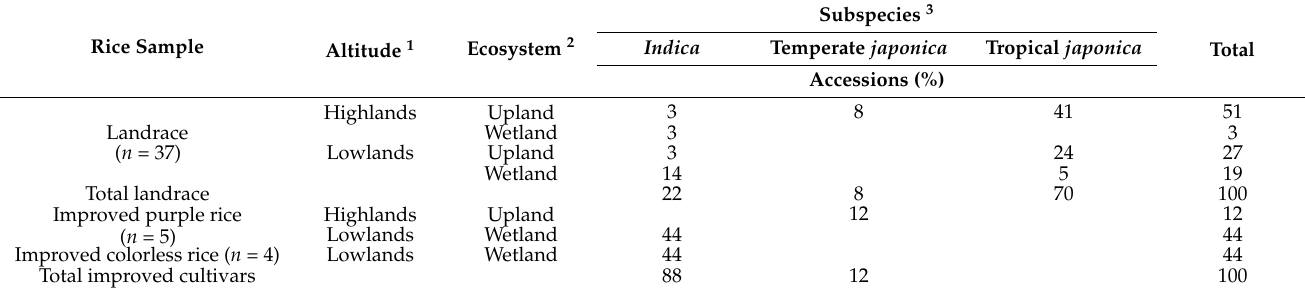
Table 1. Distribution of rice subspecies among purple rice landraces and improved rice cultivars across different altitudes and ecosystems in northern